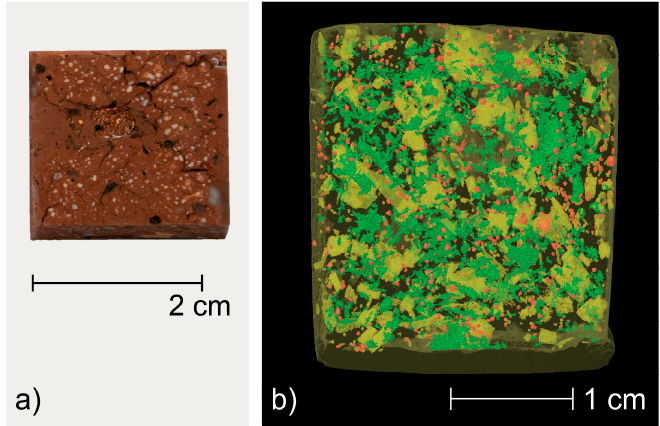
Figure 3. Standard I ( a ) impregnated with epoxy and polished; ( b ) X-ray microtomography scan (top view), visualized are only pores (green), heavy minerals, mainly magnetite (red), and some other minerals, i.e., feldspar/biotite/calcite (yellow). Please note the visualized components, including pores, appear inside the standard. The scan does not depict the components present at the outer surface of the standard.